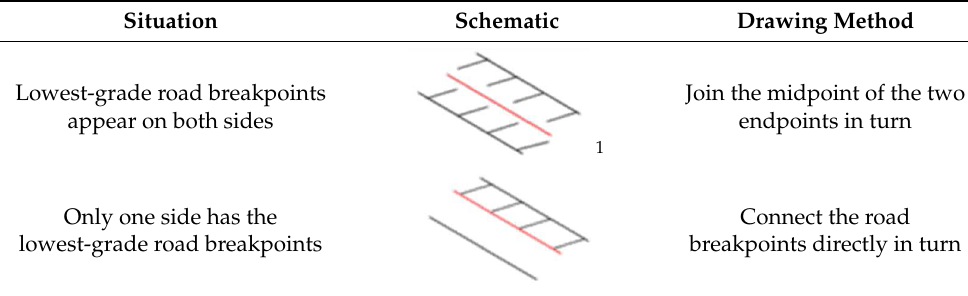
Join the midpoint of the two endpoints in turn 1 Connect the road breakpoints directly in turn